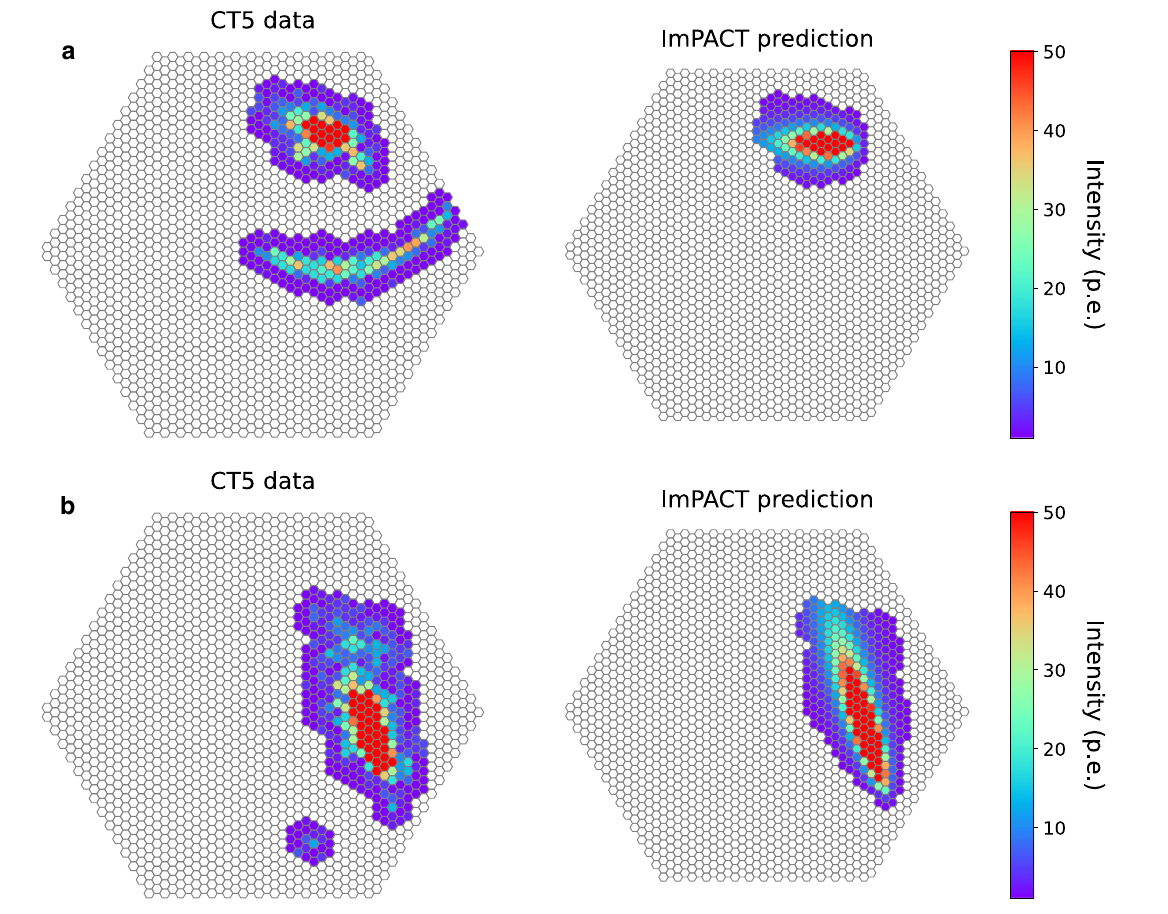
Fig. 1 Largetelescopeimagesofrejectedeventsthatwouldbelabelled as gamma-ray candidates in the small telescope reconstruction. In both cases, the right panel shows the ImPACT prediction associated with that event,whereastheleftpanelshowstheactualrecordedeventimage.The event image shown in the panel labelled as “a” contains a clear muon